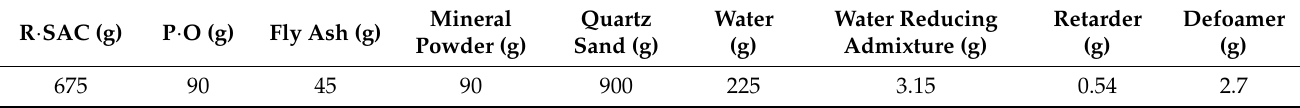
Table 10. The mixing ratio of grouting